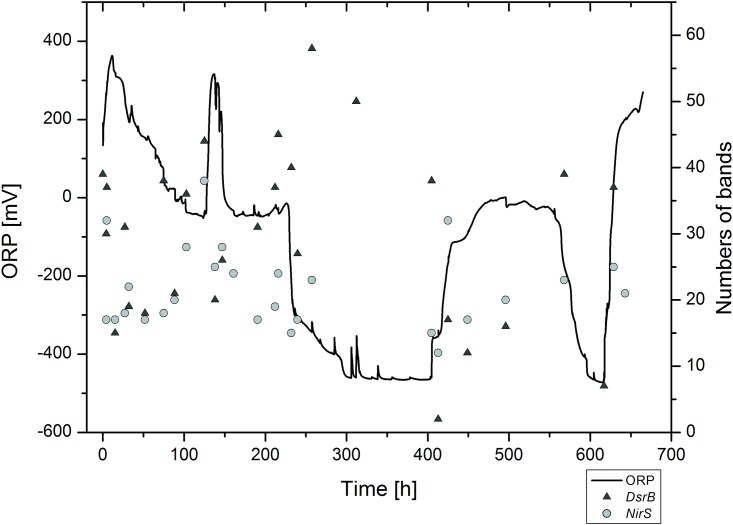
Development of dsrB and nirS DGGE band diversity in relation to ORP.